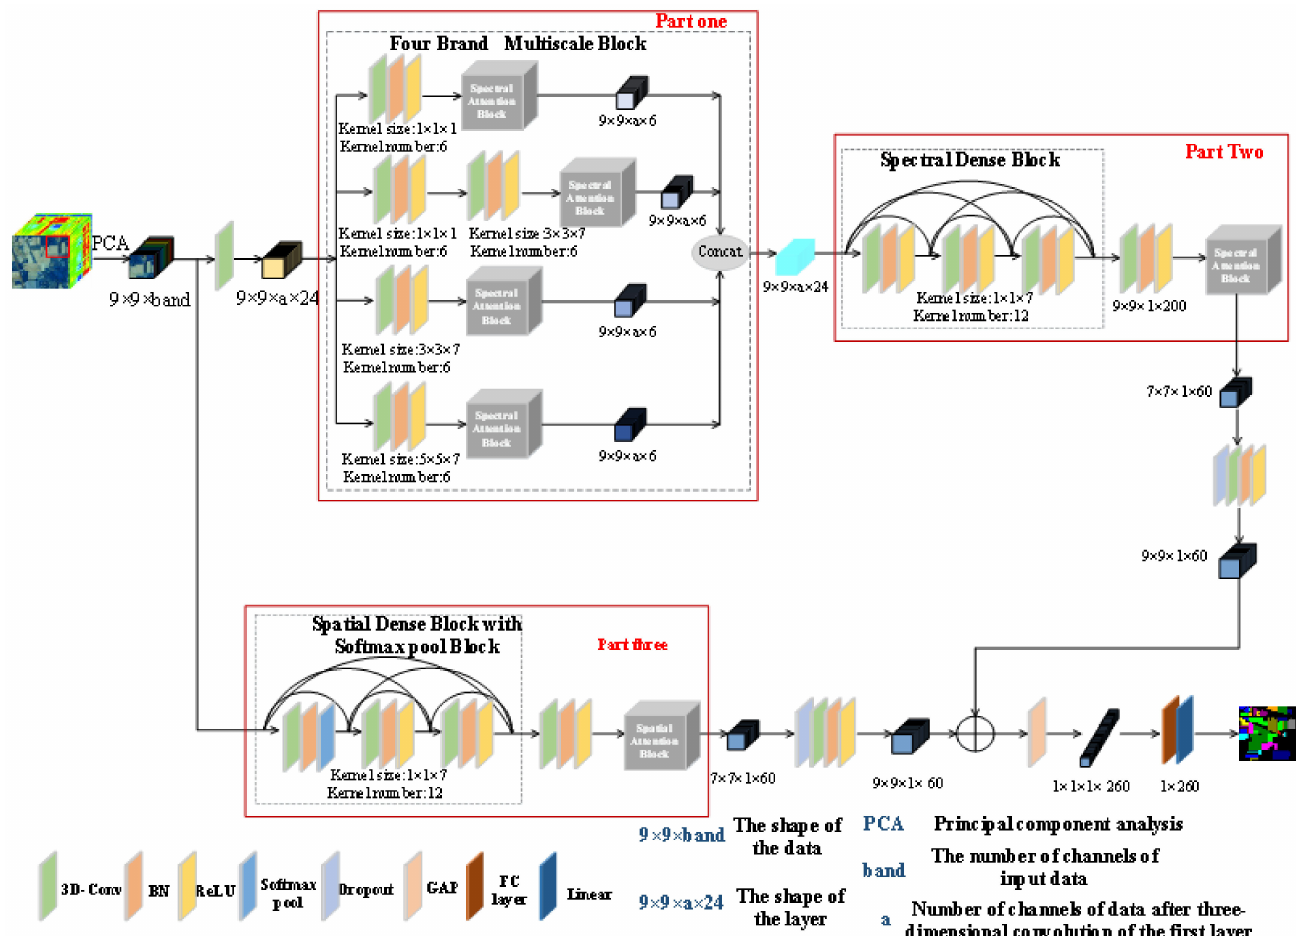
Figure 1. The overall framework of the proposed SFBMSN